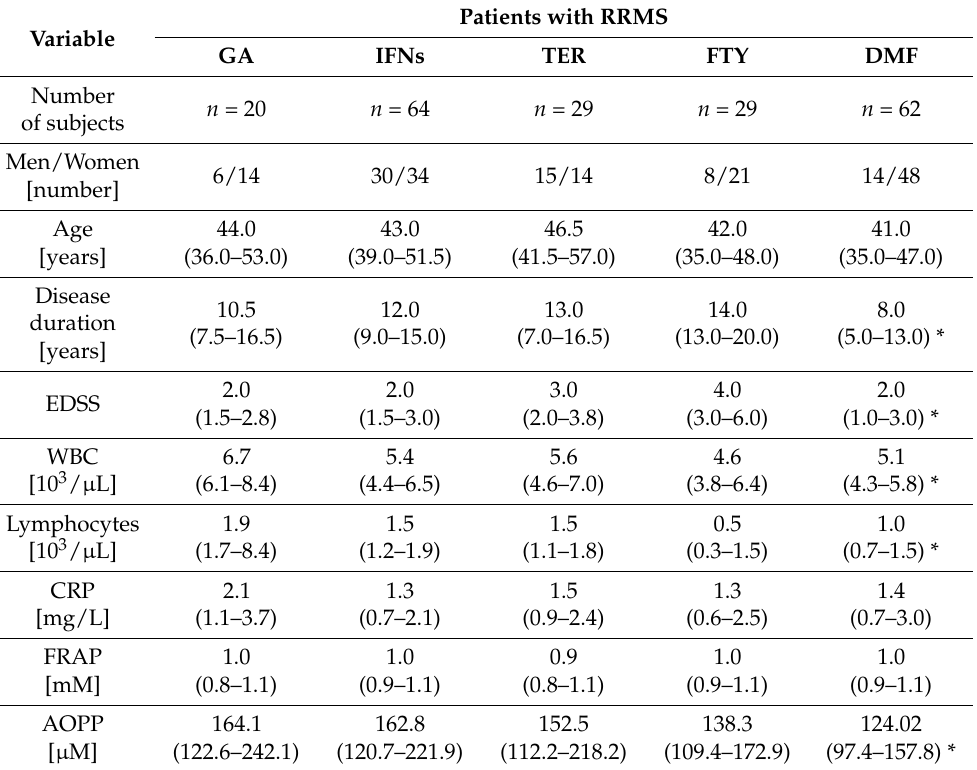
Table 4. Comparison of analyzed variables in the subgroups of RRMS patients treated with particular